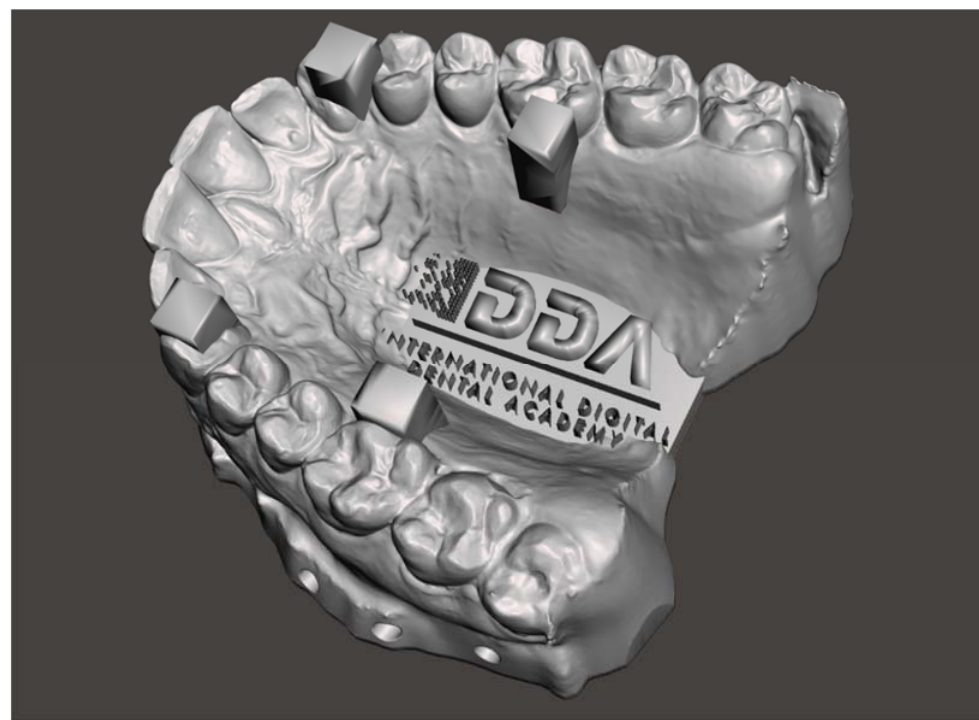
Figure 1. The IDDA Calibration Model. This master model was printed using an Asiga Max UV and NextDent Model Resin at 50-micron layer height. This printer and resin combination was chosen for high precision and low reflectivity to facilitate the acquisition with the intra-oral scanners used in the study [20].